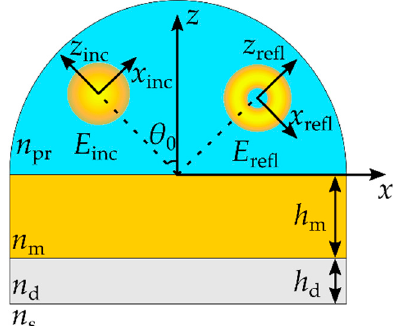
Figure 1. Geometry of the investigated structure consisting of a prism with refractive index n pr , a metal layer with refractive index n m and thickness h m , and a dielectric layer with refractive index n d and thickness h d surrounded by a medium with refractive index n s and a schematic depiction of the spatiotemporal transformation of a pulse with the envelope E inc , obliquely incident at the angle θ 0 to a reflected pulse with the envelope E refl possessing an STOV.